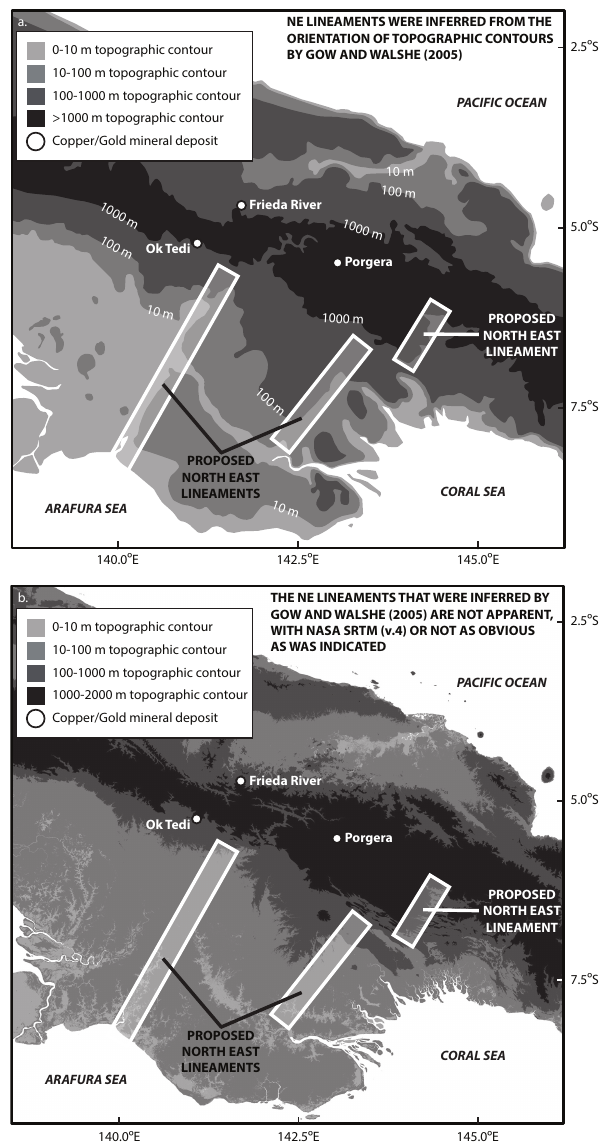
Fig. 4. (a) Gow and Walshe (2005) examined the topography of Papua New Guinea at three elevation contours (10, 100 and 1000m). From these, they saw that there were several pronounced NE striking trends. (b) However, these features are not observed when the same elevation contour intervals are generated using the NASA Shuttle Radar Topographic Mission (SRTM) (version 4) data.